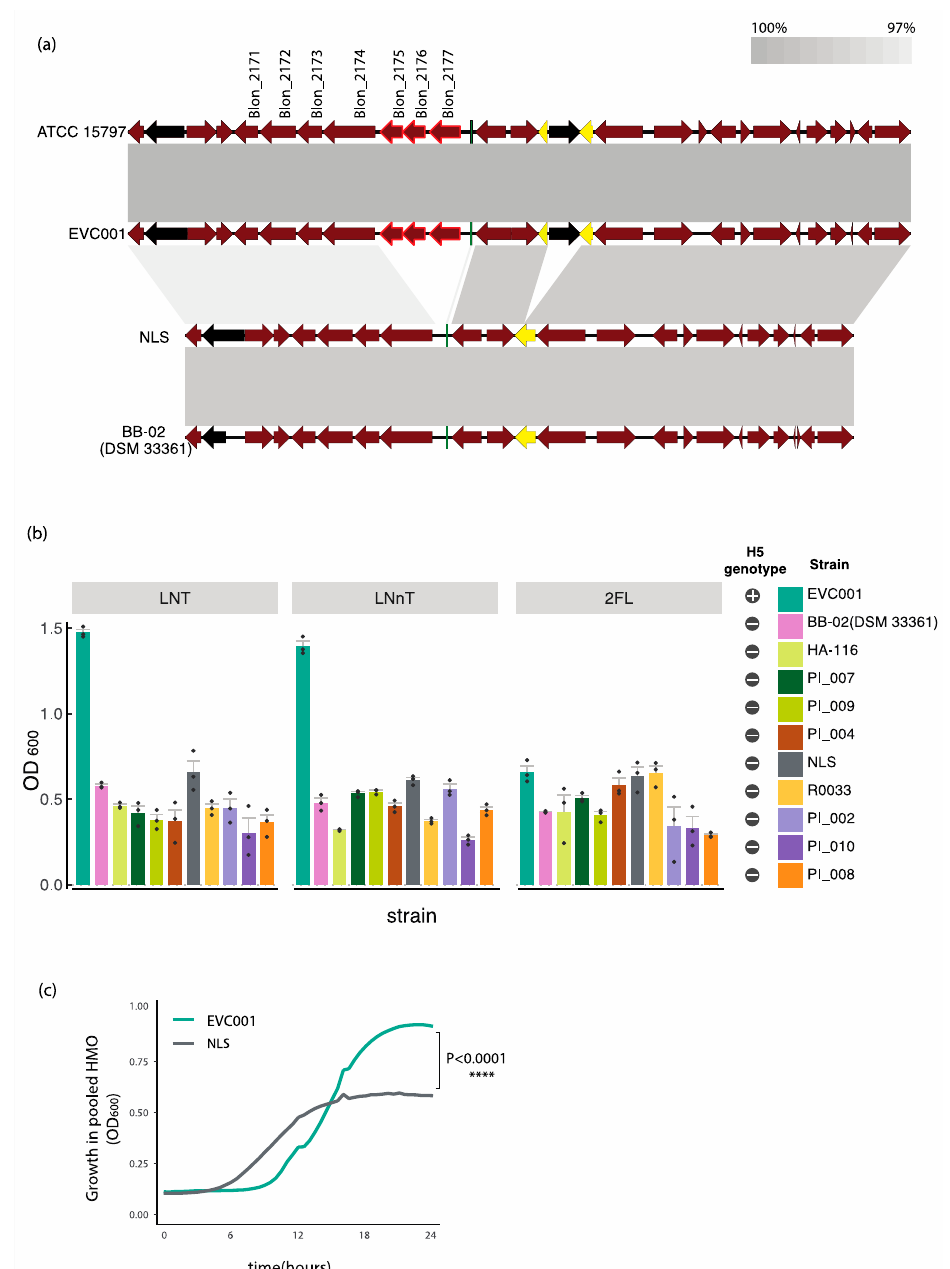
Figure 2. Alignment of a genomic region containing the H5 gene cluster and growth on purified HMOs from pooled human milk samples. ( a ) Genomic map of the H5 cluster and flanking of representative Group 1 (EVC001) and Group 2 (NLS and BB-02) strains compared to type strain. Genes belonging to the H5 cluster in type strain ATCC 15697 are annotated with the corresponding “Blon_” locus tag. Homologous segments are indicated by greyscale blocks. Genes absent in the NLS strain are highlighted in red. tRNAs are colored in green, truncated genes are colored in yellow and mobile genetic elements are colored in black. ( b ) Growth of B infantis strains isolated from infant probiotics on MRS medium containing lacto- N -tetraose (LNT), lacto- N -neotetraose (LNnT), or 2 (cid:48) -fucosyllactose (2 (cid:48) -FL) as the carbon source. Data represents the mean ± SD of three independent measurements. H5 genotype is indicated with a plus ( + ; H5 positive) or a minus sign ( − ; H5 negative). Colors representing the strains are correspond to the circular genome map in Figure 1. ( c ) Growth curves of B. infantis EVC001 and B. infantis NLS growing in RPMI medium containing purified HMOs from donor breast milk, **** p <